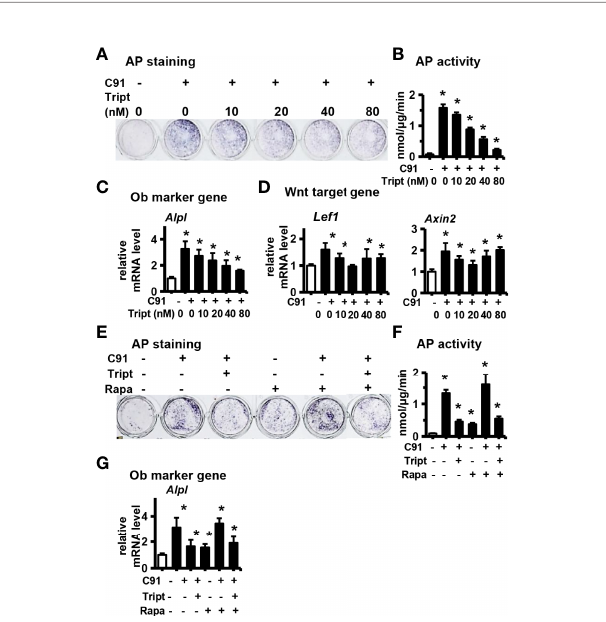
FIGURE 6 | Study the relationship between autophagy and Wnt/ b -catenin signaling pathway. ST2 cells were treated with Wnt signaling inhibitors Triptonide(Tript) (10nM, 20nM, 40nM, 80nM) and C91 (5 m M) for 3 days, and the samples were collected for AP staining analysis (A) and AP biochemical quantitative analysis (B) . (C, D) qRT-PCR detection of osteogenic target gene and Wnt target gene mRNA expression. Tript at a concentration of 80nM inhibited the osteogenic differentiation of ST2 the best. Rapamycin (Rapa) is an autophagy activator. ST2 cells were treated with C91, Tript (80nM) and Rapamycin (200nM) for 3 days, and the samples were collected for AP staining analysis (E) and AP biochemical quantitative analysis (F) . (G) The expression of Alpl mRNA, an early osteogenic factor, was detected by qRT- PCR. Results are expressed as mean ± SD (n = 3 per group). * indicates P <0.05, compared with DMSO